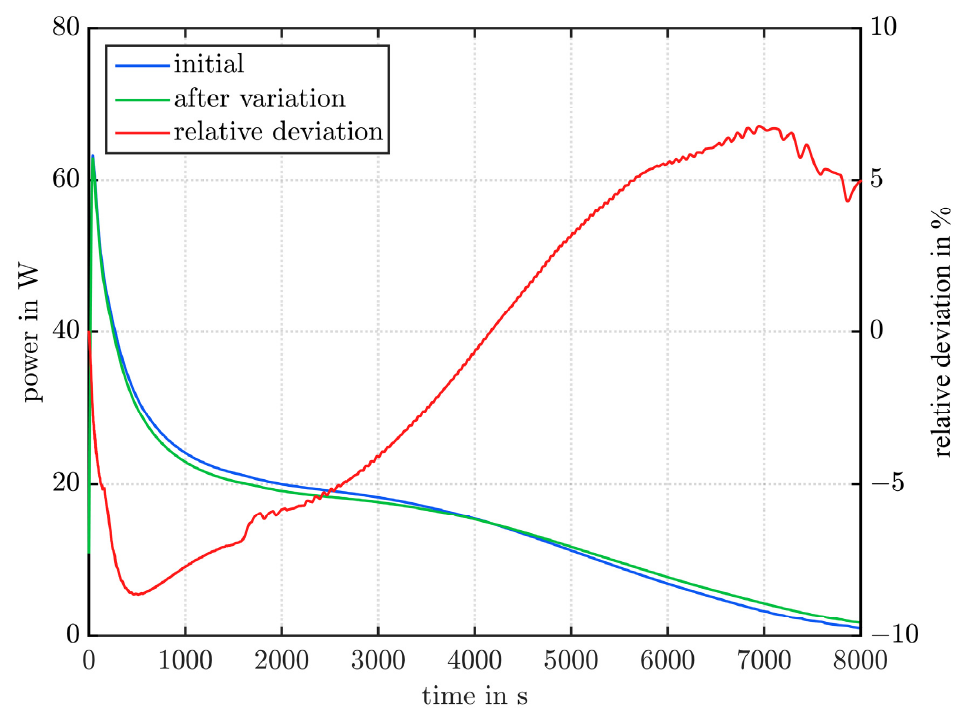
Figure A1. Power over time curve for charging of the standard case and the case with a decreased melting enthalpy as well as the regarding relative deviation.